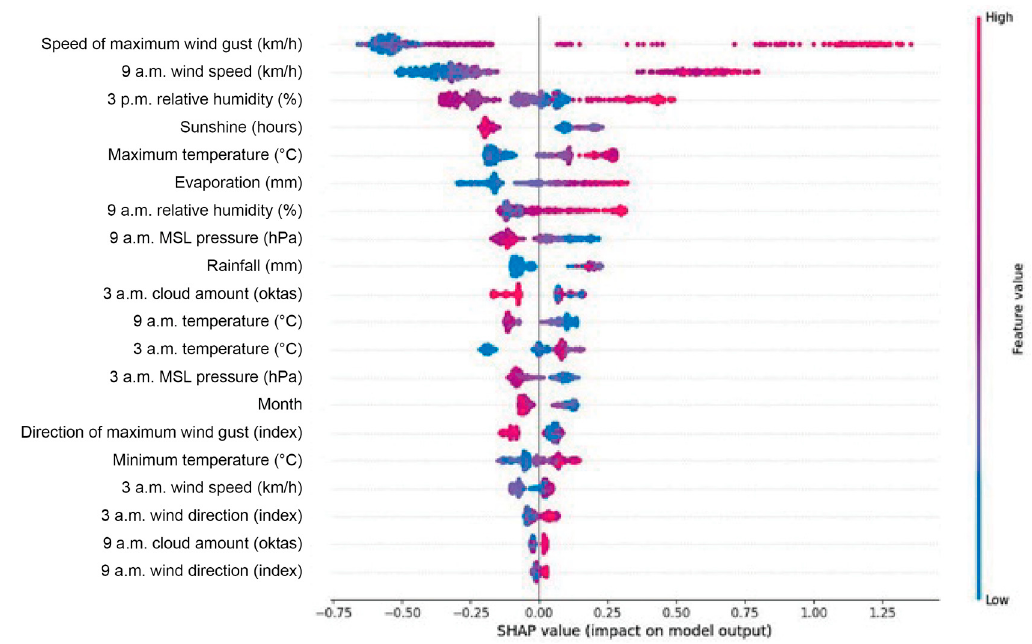
Figure 10. SHAP explanation of the summary plot.